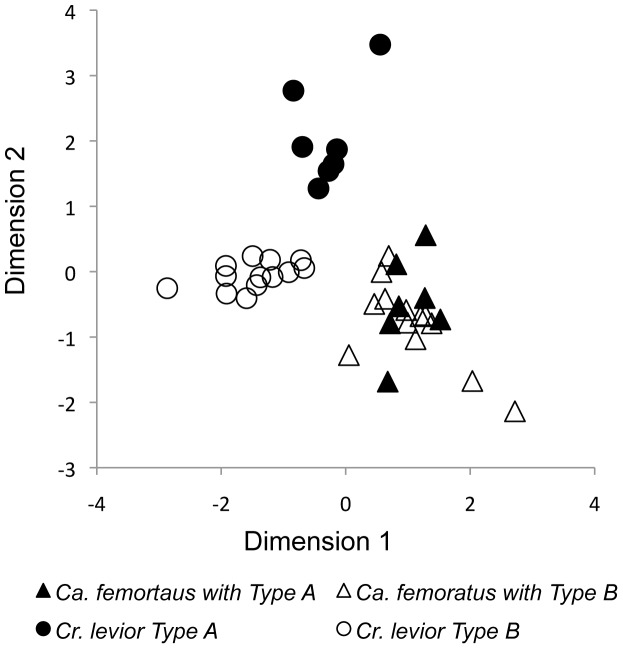
Nonmetric multidimensional scaling plot of the relative proportions of 45 cuticular hydrocarbon peaks from pooled ant profiles.Each shape represents the pooled profile of 30 Cr. levior or 5 Ca. femoratus worker ants of a different colony (n = 20 colonies).